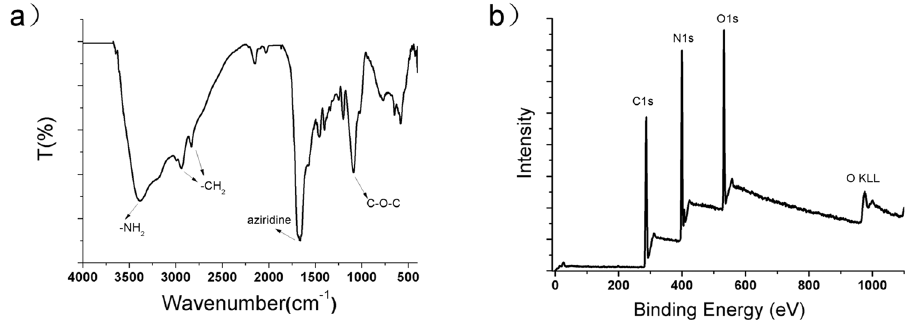
Figure 4. ( a ) FTIR spectrum (at 50 mW/cm 2 ) and ( b ) XPS survey spectrum of the photogenerated solid N-dots.